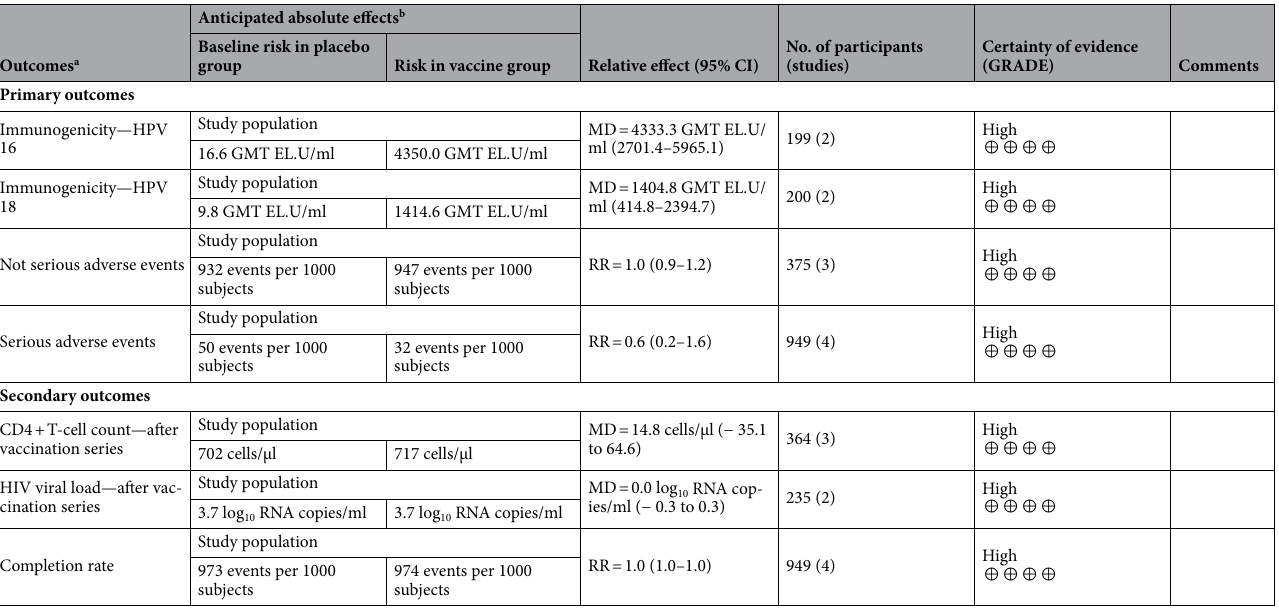
Table 1. Summary of findings. Population: HIV-infected subjects. Setting: any; studies conducted in: South Africa, Spain, USA, Brazil. Intervention: bivalent or quadrivalent HPV Vaccine. Comparison: placebo. a The present summary of findings only considers primary and secondary outcome that were present in more than one study and that were eligible for data synthesis. b For quantitative outcomes, the absolute baseline risk was the median value calculated over the mean values reported for the vaccine group in the included studies, whereas for dichotomous outcomes it was the median value calculated over the risks reported for the vaccine group in the included studies. The absolute risks in vaccine groups were calculated using the anticipated absolute effect in the placebo group and the relative effect measure. 95% CI 95% confidence interval, RR risk ratio, MD mean difference. GRADE Working Group grades of evidence. High certainty: we are very confident that the true effect lies close to that of the estimate of the effect; Moderate certainty: we are moderately confident in the effect estimate: the true effect is likely to be close to the estimate of the effect, but there is a possibility that it is substantially different; Low certainty: our confidence in the effect estimate is limited: